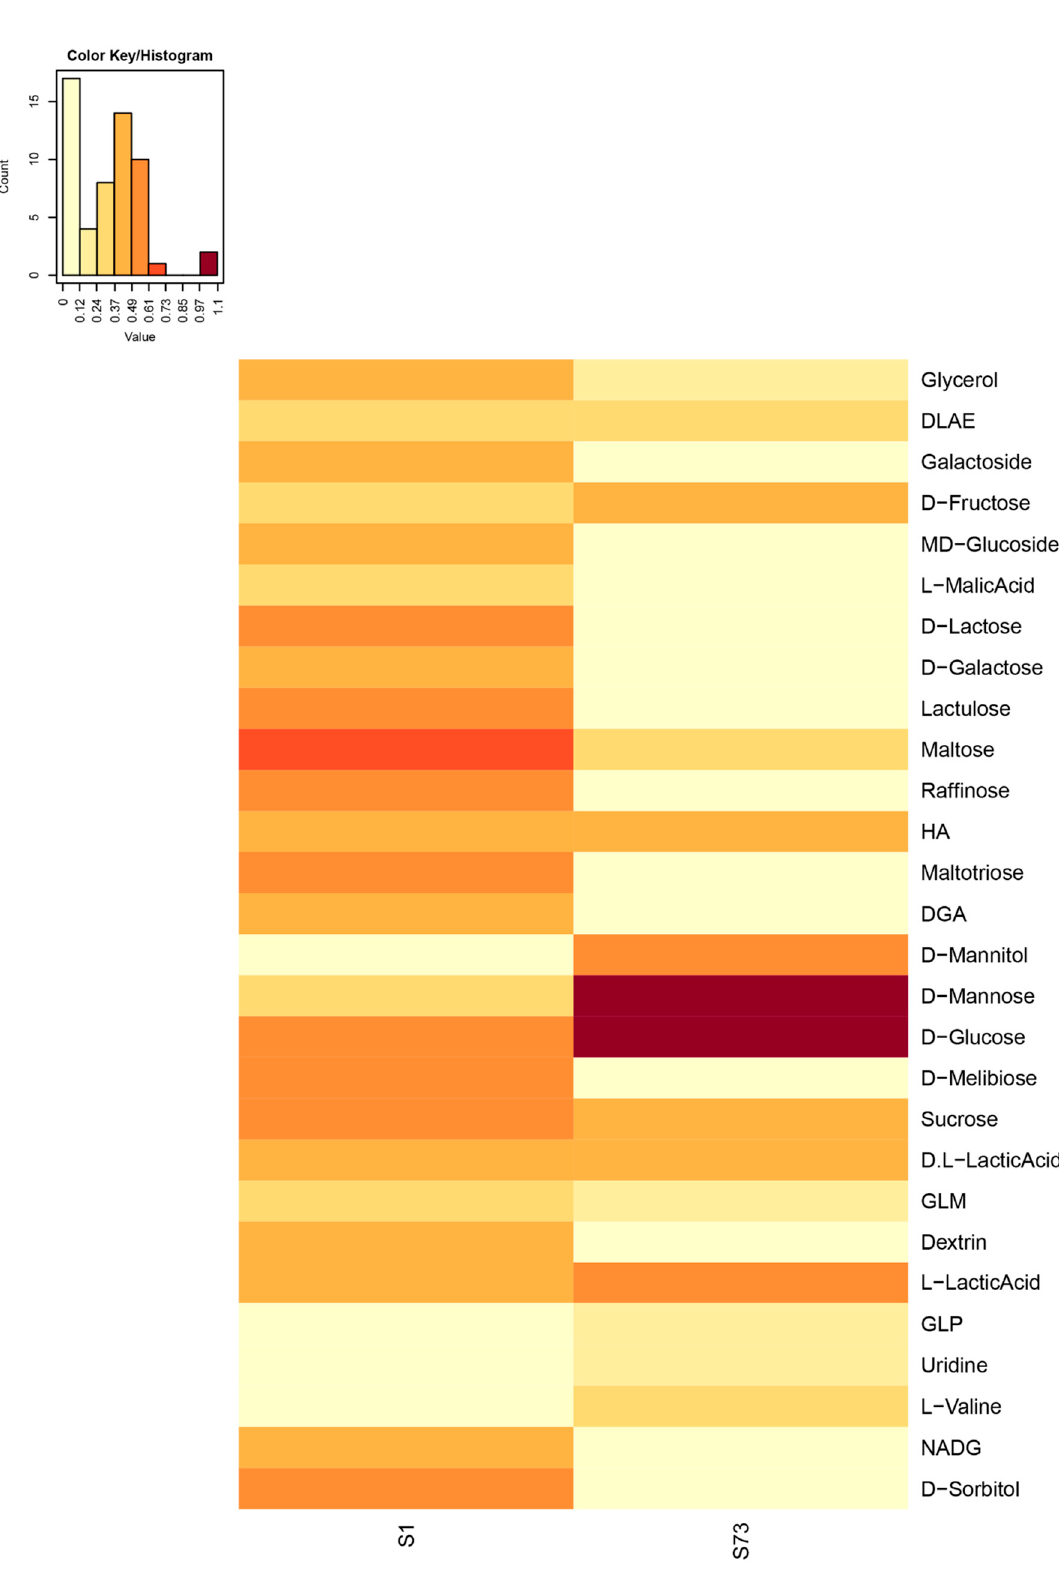
Figure 1. Metabolic fingerprint of the probiotic Lactobacillus strains. DLAE = D-Lactic Acid Methyl Ester. HA = α - Hydroxybutyric Acid. DGA = D-Galacturonic Acid. GLM = Glycyl-L-Methionine. GLP = Glycyl-L-Proline. NADG = N-Acetyl-D-Glucosamine. S1 = L. salivarius . S73 = L.agilis .